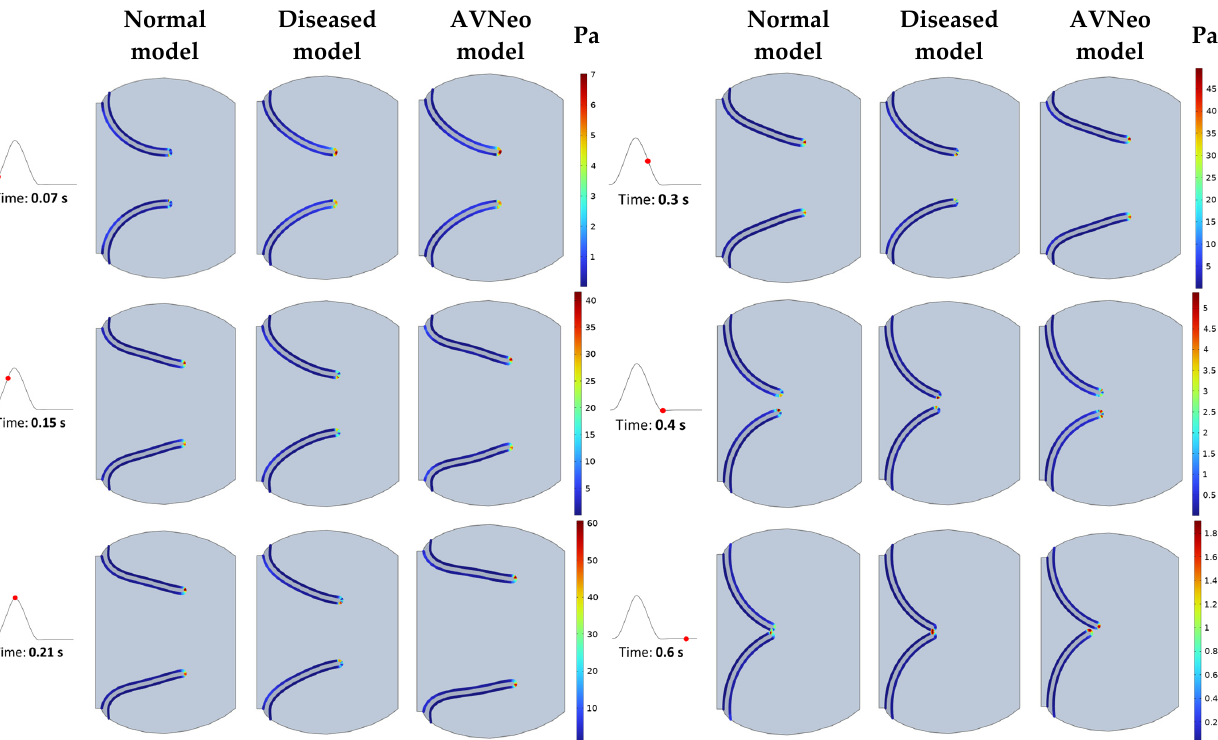
Left column—model results; right column—* in vivo and in vitro experimental data, ** numerical experiment data.